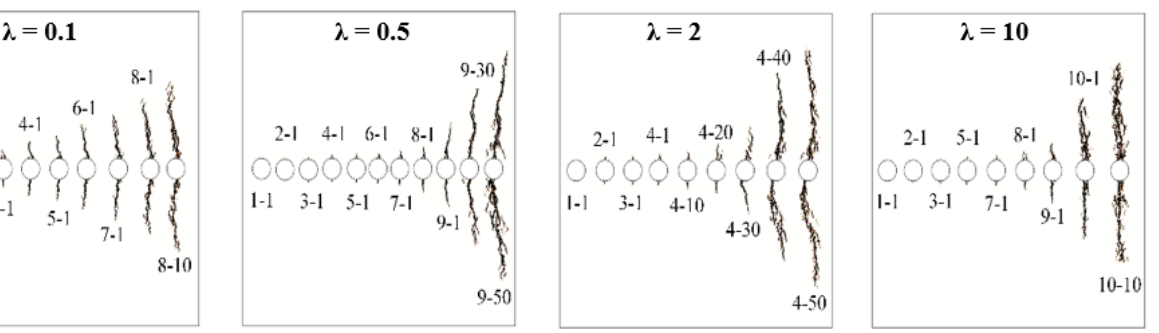
Figure 12. Crack propagation law of fracturing hole under different λ when ξ = 0.5.